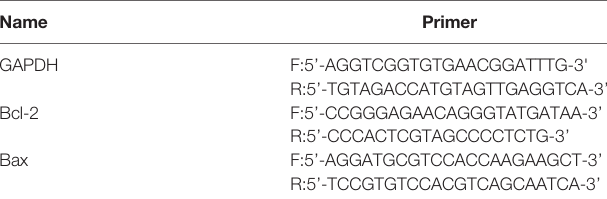
TABLE 2 | The primers sequence used for real-time quantitative PCR.